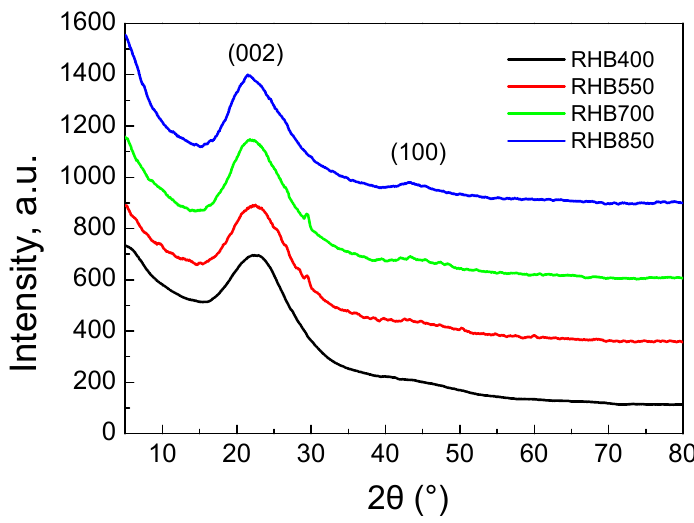
Figure 4. X-ray diffraction (XRD) patterns of the studied biochars.